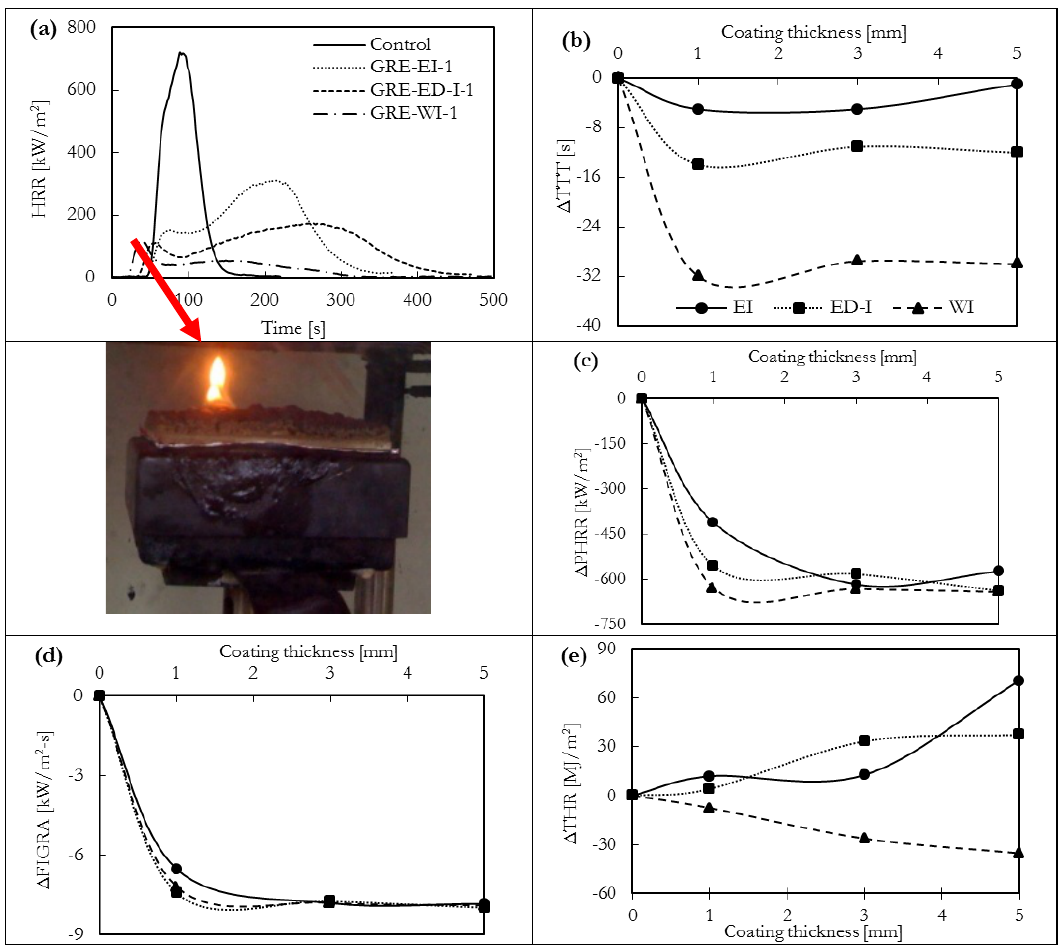
Figure 4. ( a ) Heat release rate (HRR) versus time curves of control and coated samples of 1 mm coating of each type; and difference in ( b ) time-to-ignition (TTI), ( c ) peak heat release rate (PHRR), ( d ) fire hazard index (FHI) and ( e ) total heat release (THR) of each coated sample w.r.t control sample as a function of coating thickness.